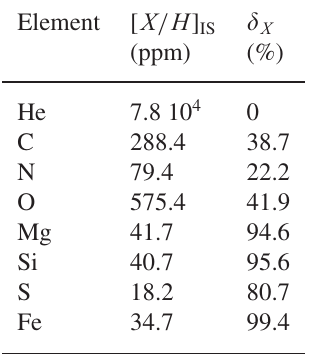
Table 1. Interstellar abundances of elements [22] and depletion factor (cid:1) X for the (cid:2) oph line of sight representative of the cold, diffuse ISM ( T ∼ 100K and n H ∼ 100cm − 3 , see